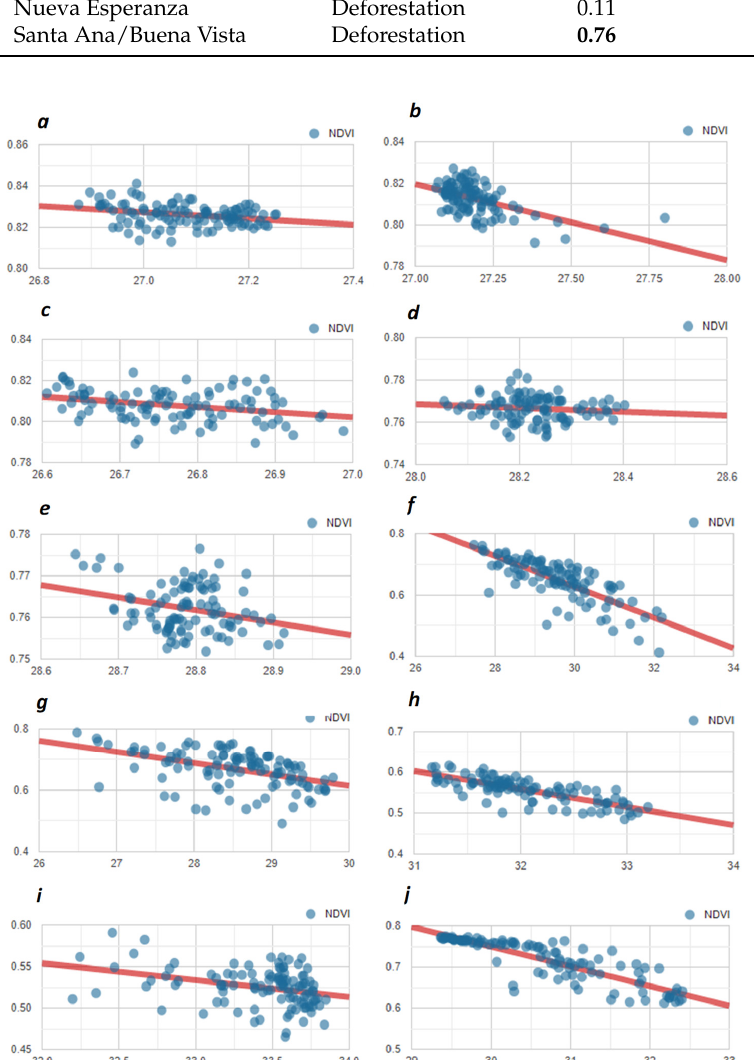
Figure 9. Relationship between NDVI and daytime LST (°C) values in forested and deforested areas in the Chiquitania region (2001–2021). The red line represents the trend line of the data points. Sites with intact forest: ( a ) Noel Kempff, ( b ) Bajo Paraguá, ( c ) Monteverde, ( d ) San Rafael, and ( e ) Tucabaca. Sites with deforestation: ( f ) San Ignacio, ( g ) Concepción, ( h ) El Cerro/California, ( i ) Nueva Esperanza, and ( j ) Santa Ana/Buena Vista.